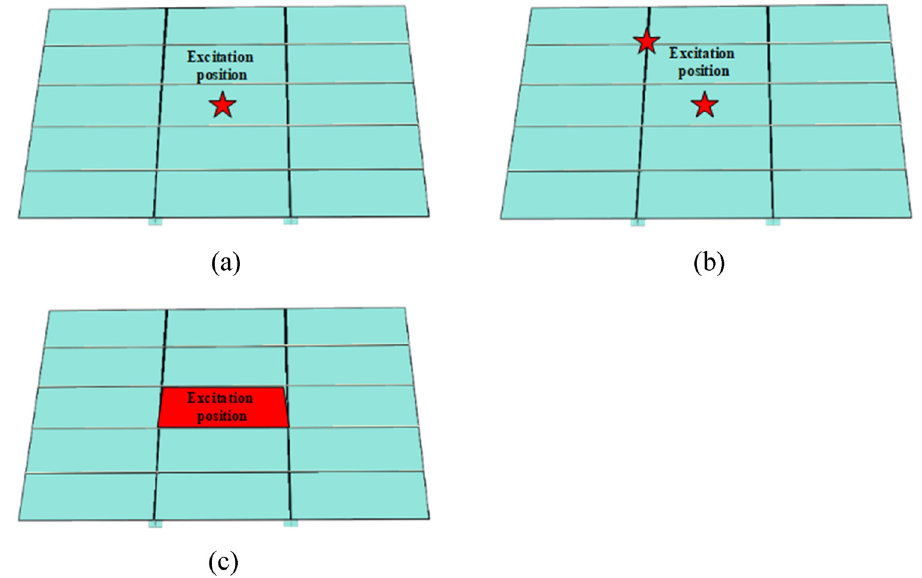
Figure 11: Loading position of di ff erent kinds of excitation: ( a ) single - point excitation, ( b ) two - point excitation, and ( c ) uniform distribution excitation.